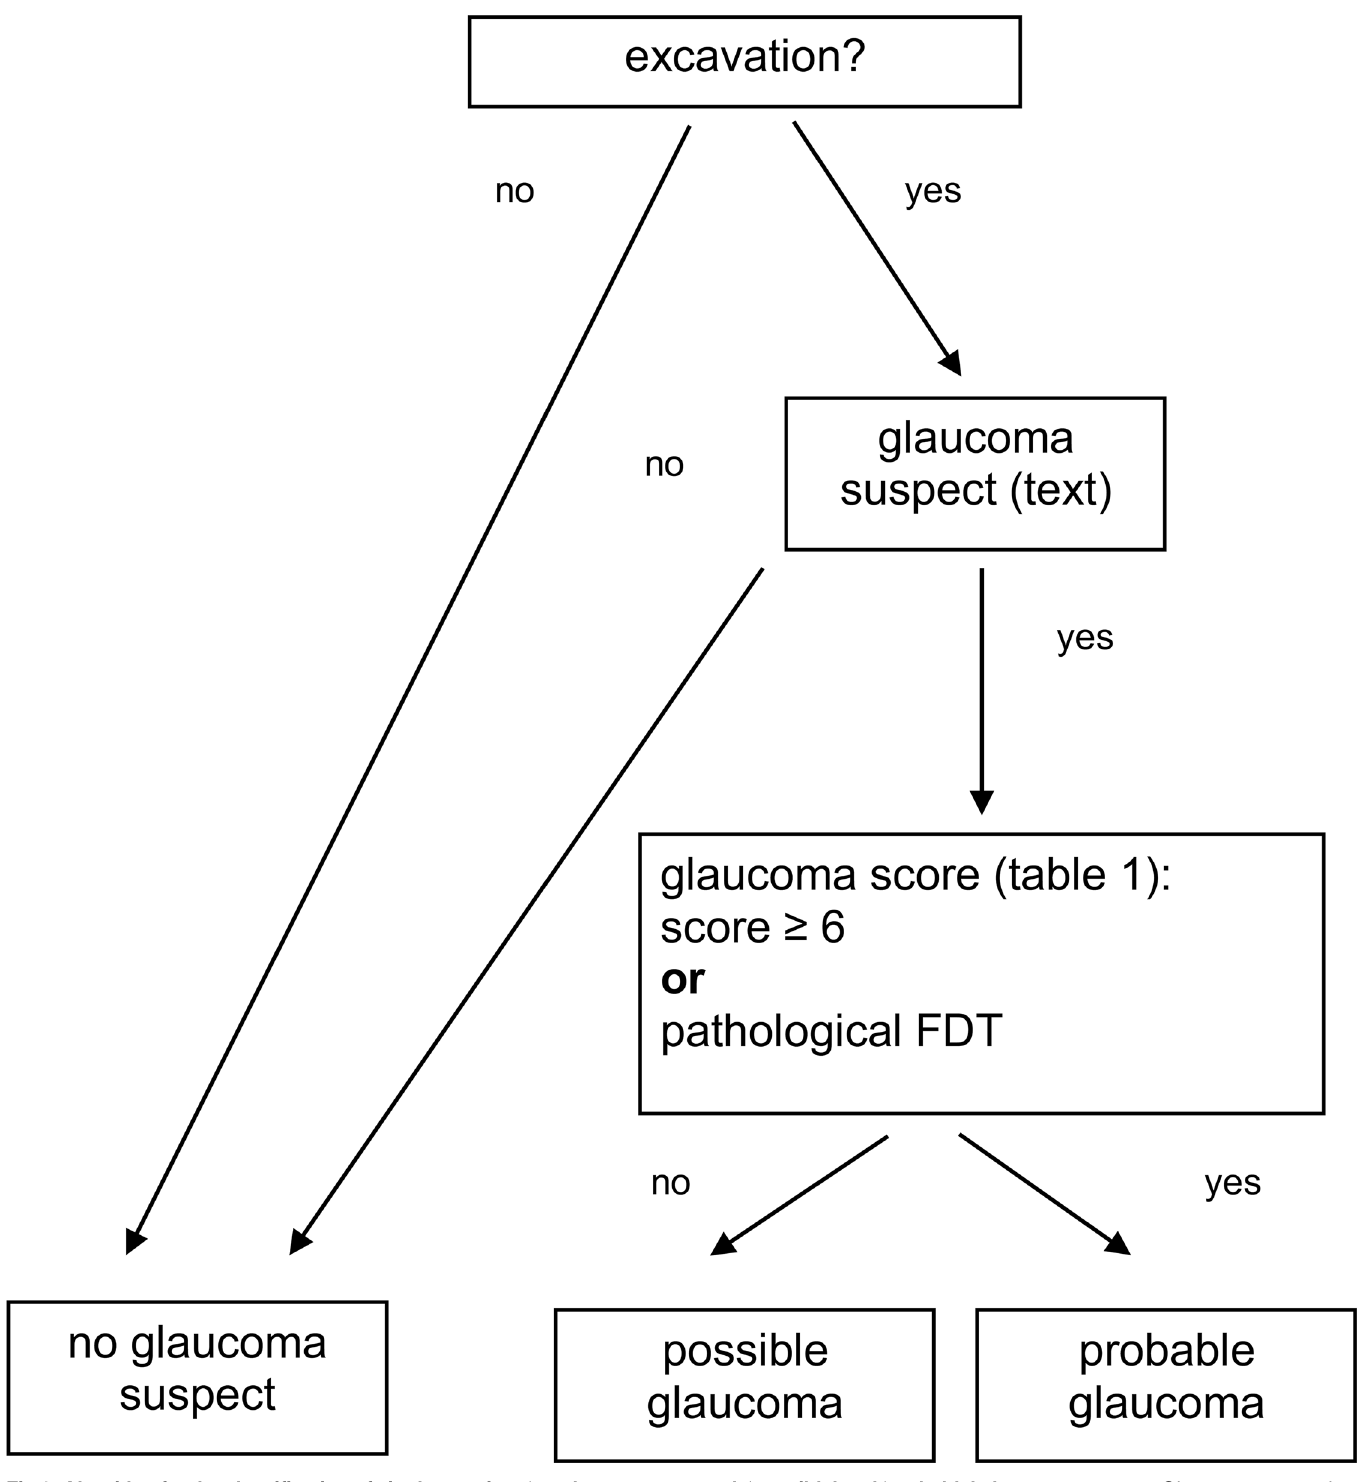
Fig 1. Algorithm for the classification of single eyes into ‘ no glaucoma suspect ’ , ‘ possible ’ and ‘ probable ’ glaucoma suspect. Glaucoma suspect is defined in the text, for the glaucoma score definition see Table 1.